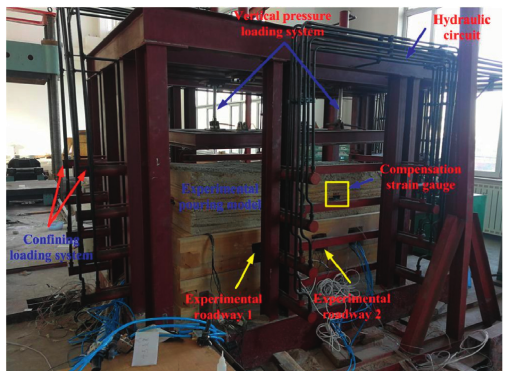
Figure 6: Frame system of the test bench and building completion model.